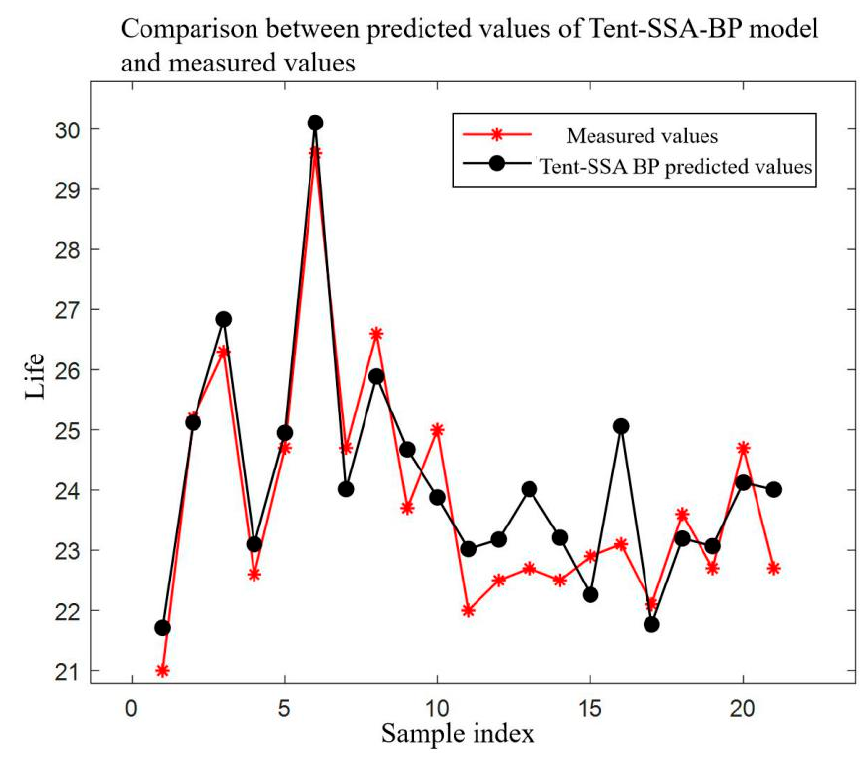
Figure 16. Comparison of the predicted life and measured life.